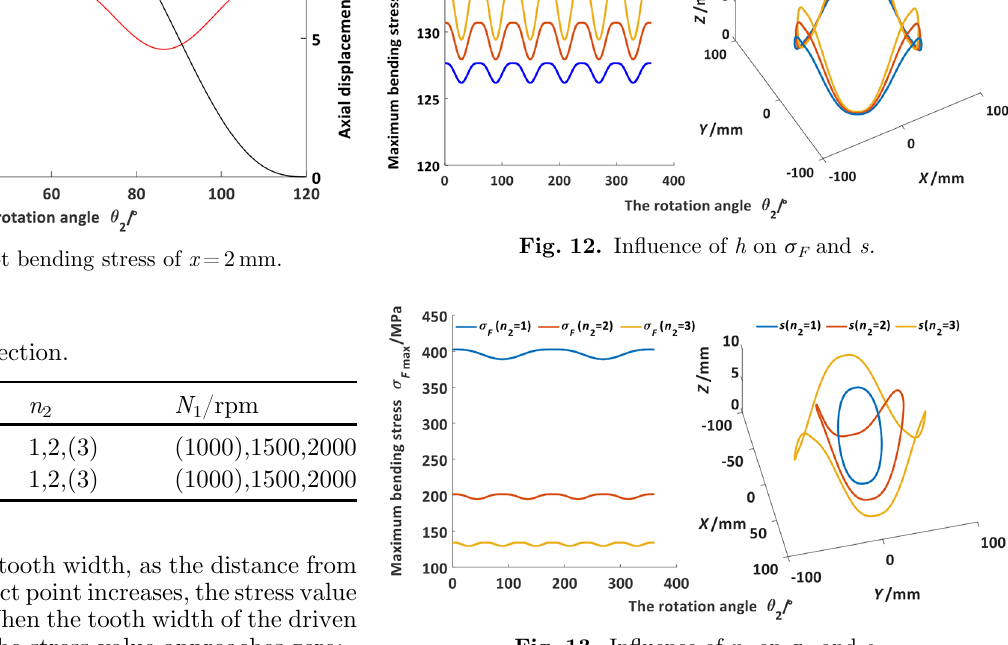
Fig. 13. In fl uence of n 2 on s F and s